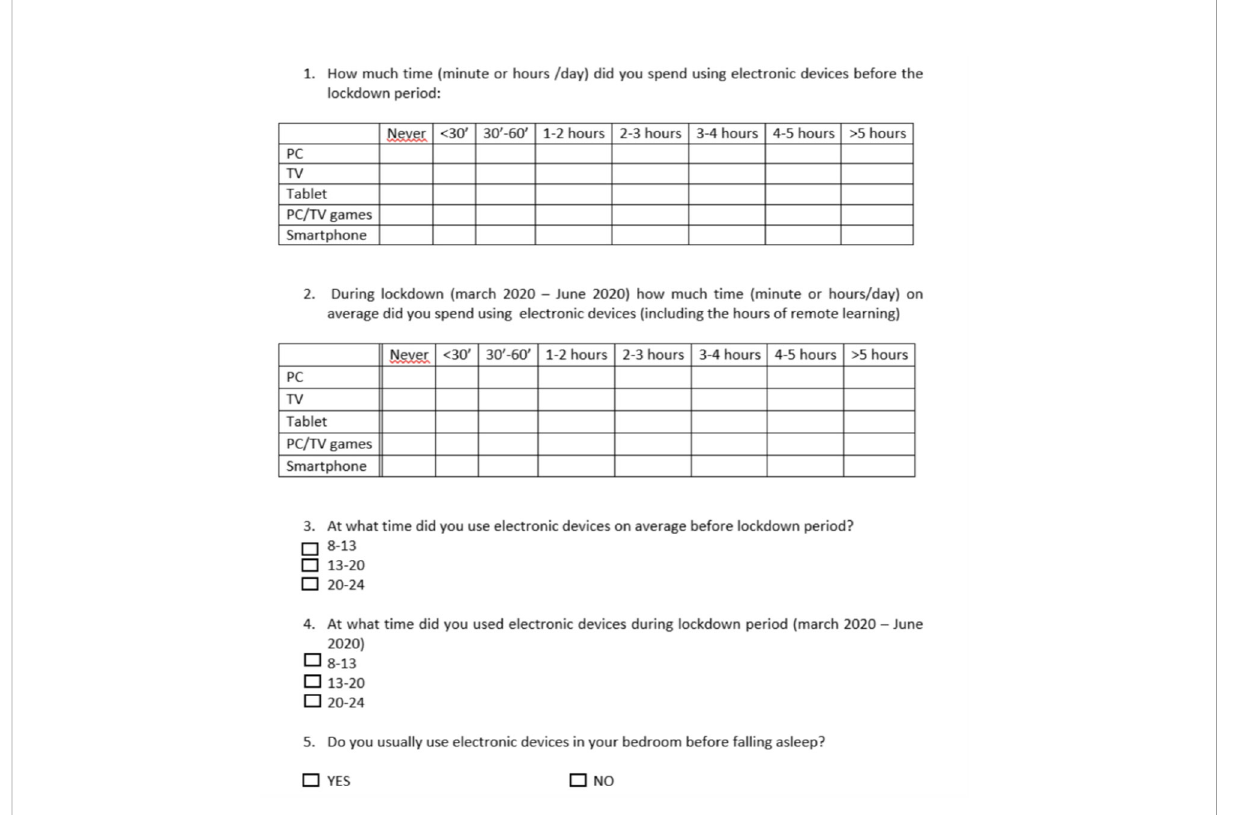
FIGURE 1 Questionnaire regarding the use of electronic